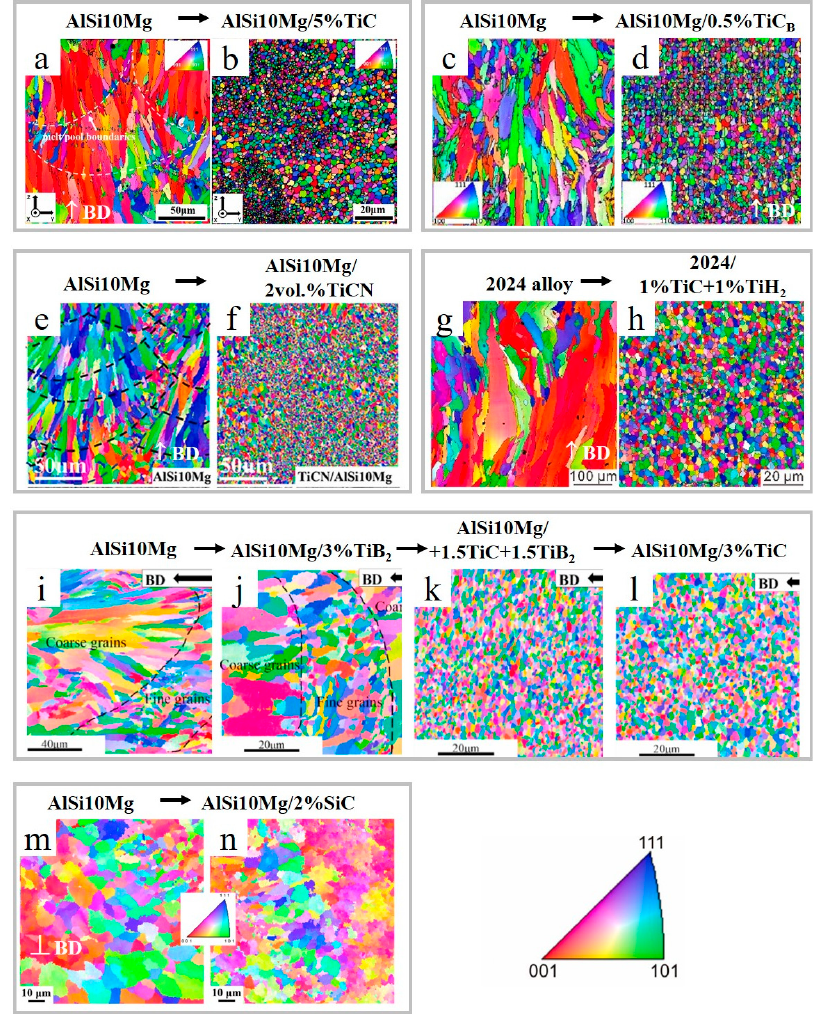
Figure 11. EBSD color maps for LPBF-prepared Al alloys and AMCs reinforced with carbides, carbonitride, carbide/hydride and carbide/boride additives ( a )–( n ) (reproduced with permission from [31,88,91–93]). Table 2. Characteristics of carbide reinforced AMCs fabricated by laser powder-bed fusion.